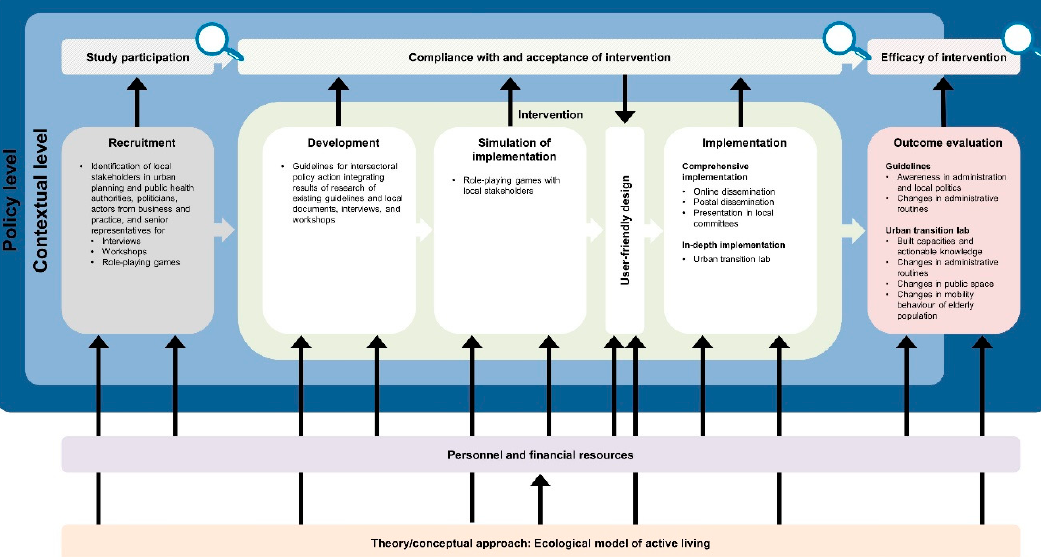
Figure 6. Specific equity-focused logic model for the contextual- and policy-level intervention focusing on intersectoral policy action to promote mobility and age-friendly municipal development implemented in AFOOT.